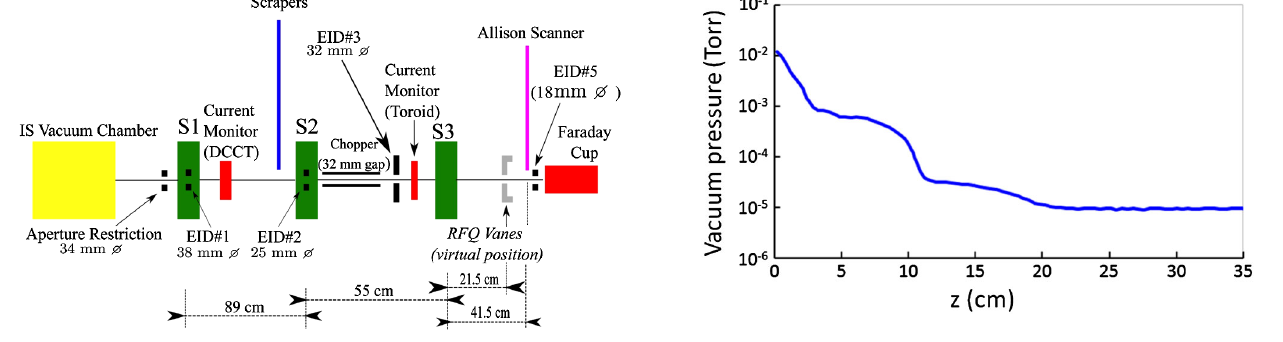
FIG. 7. Beam line schematic. 3 ” beam pipe (OD) unless otherwise noted; Faraday cup aperture is Ø 67 mm.